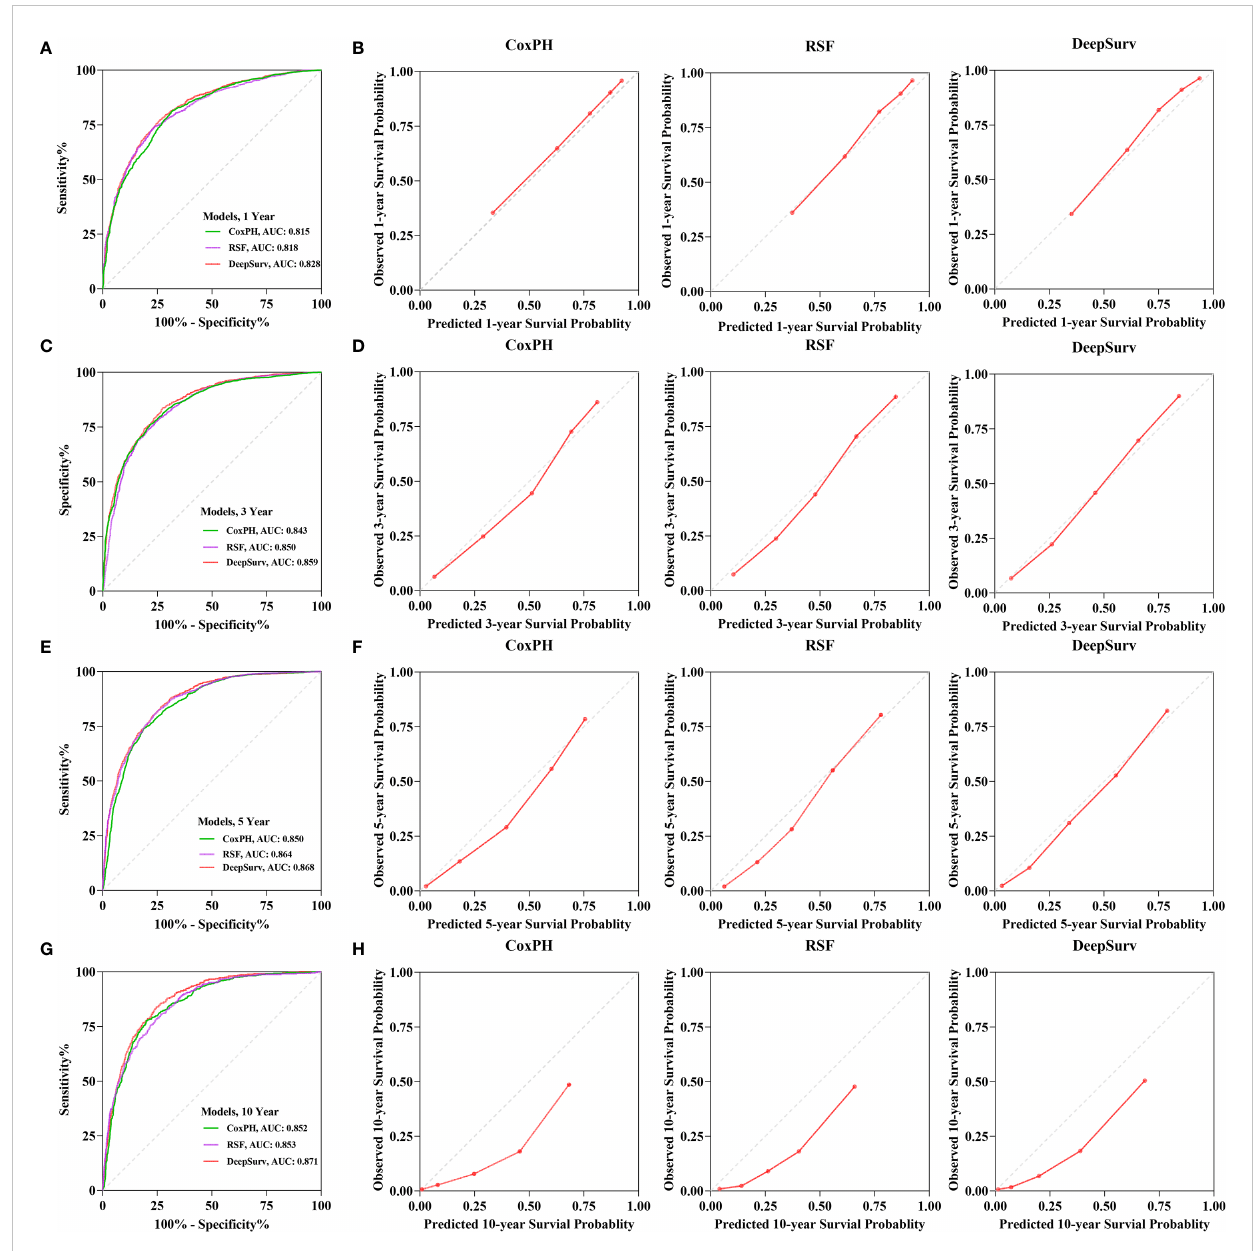
FIGURE 5 The receiver operating curves (ROC) and calibration curves for 1-, 3-, 5-, 10-year survival predictions. ROC curves for (A) 1-, (C) 3-, (E) 5-, (G) 10- year survival predictions. calibration curves for (B) 1-, (D) 3-, (F) 5-, (H) 10- year survival